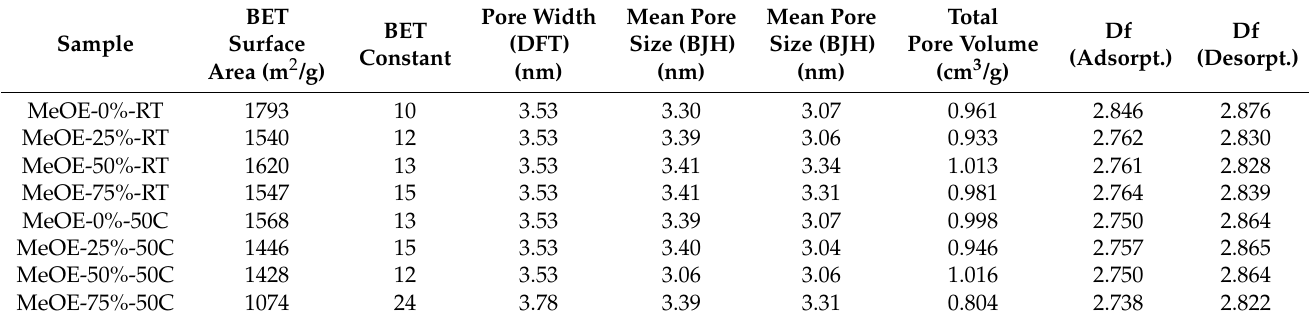
Table 1. Textural parameters of the calcined MCM-41